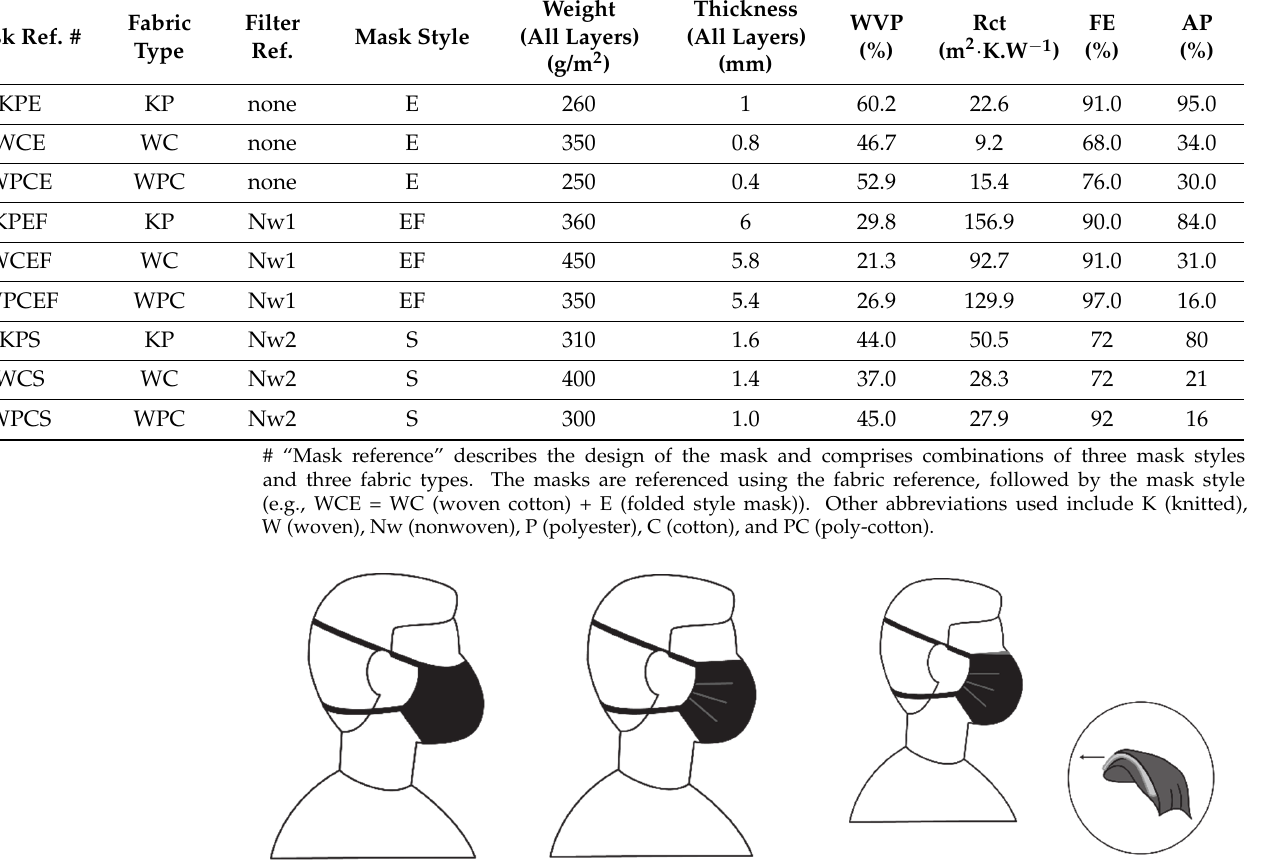
( c ) Figure 2. Microscope images of fabrics used as inner and outer layers (scale = 500 µm). ( a ) Weft- knit polyester; ( b ) woven cotton; ( c ) woven polycotton. The filtration efficiency (FE) and air permeability (AP) of the selected fabrics were measured by Gericke, et al. [22] using a method that utilizes upstream and downstream particle count measurements to calculate FE (%) and AP (%). Fabric thickness (mm) was measured with a John Bull Imperial Indicator. Fabric weight (g/m 2 ) was determined ac-